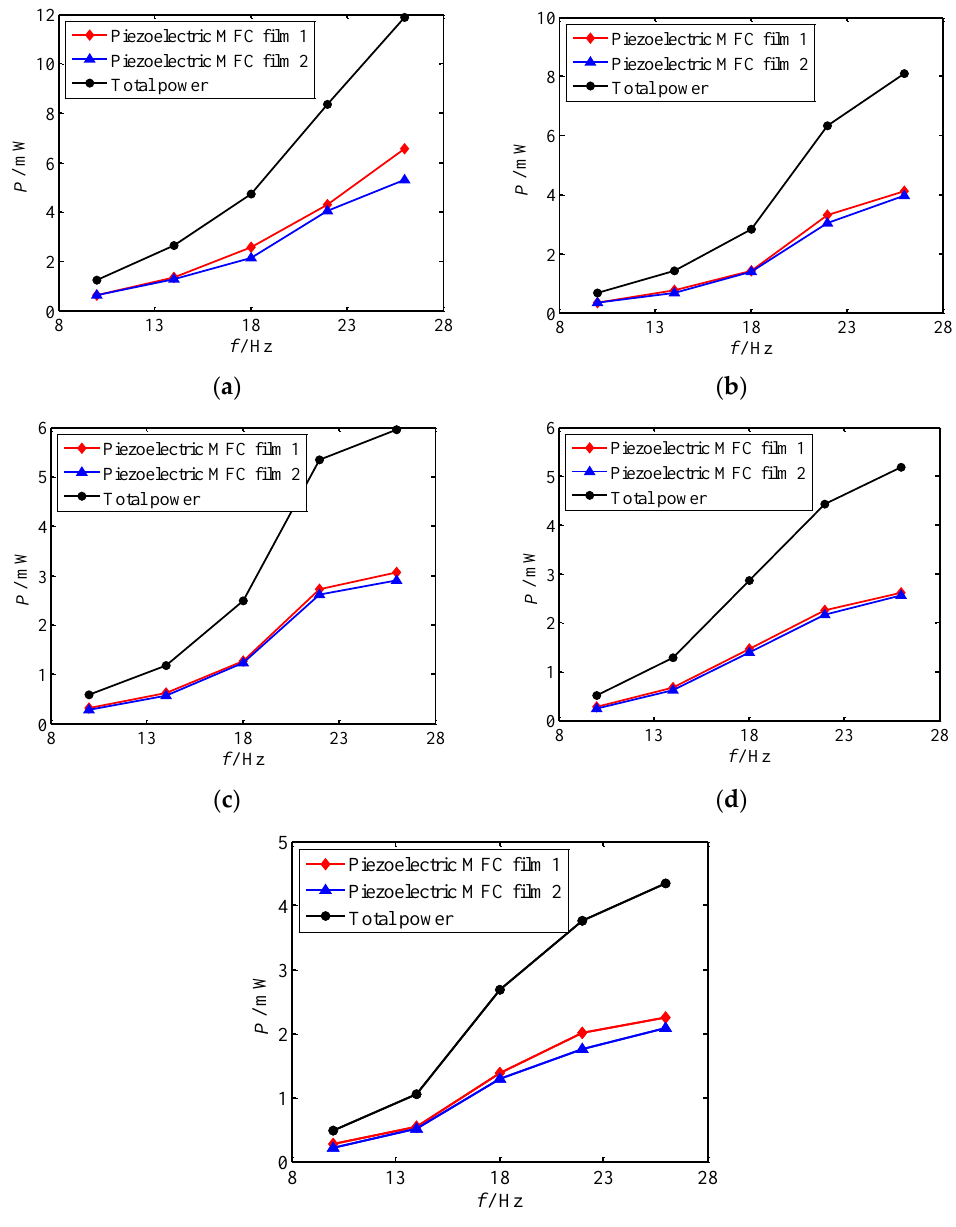
Figure 12. The output power varies with the excitation frequency under different load resistance. ( a ) R = 10 kΩ; ( b ) R = 20 kΩ; ( c ) R = 30 kΩ; ( d ) R = 40 kΩ; ( e ) R = 50 kΩ.